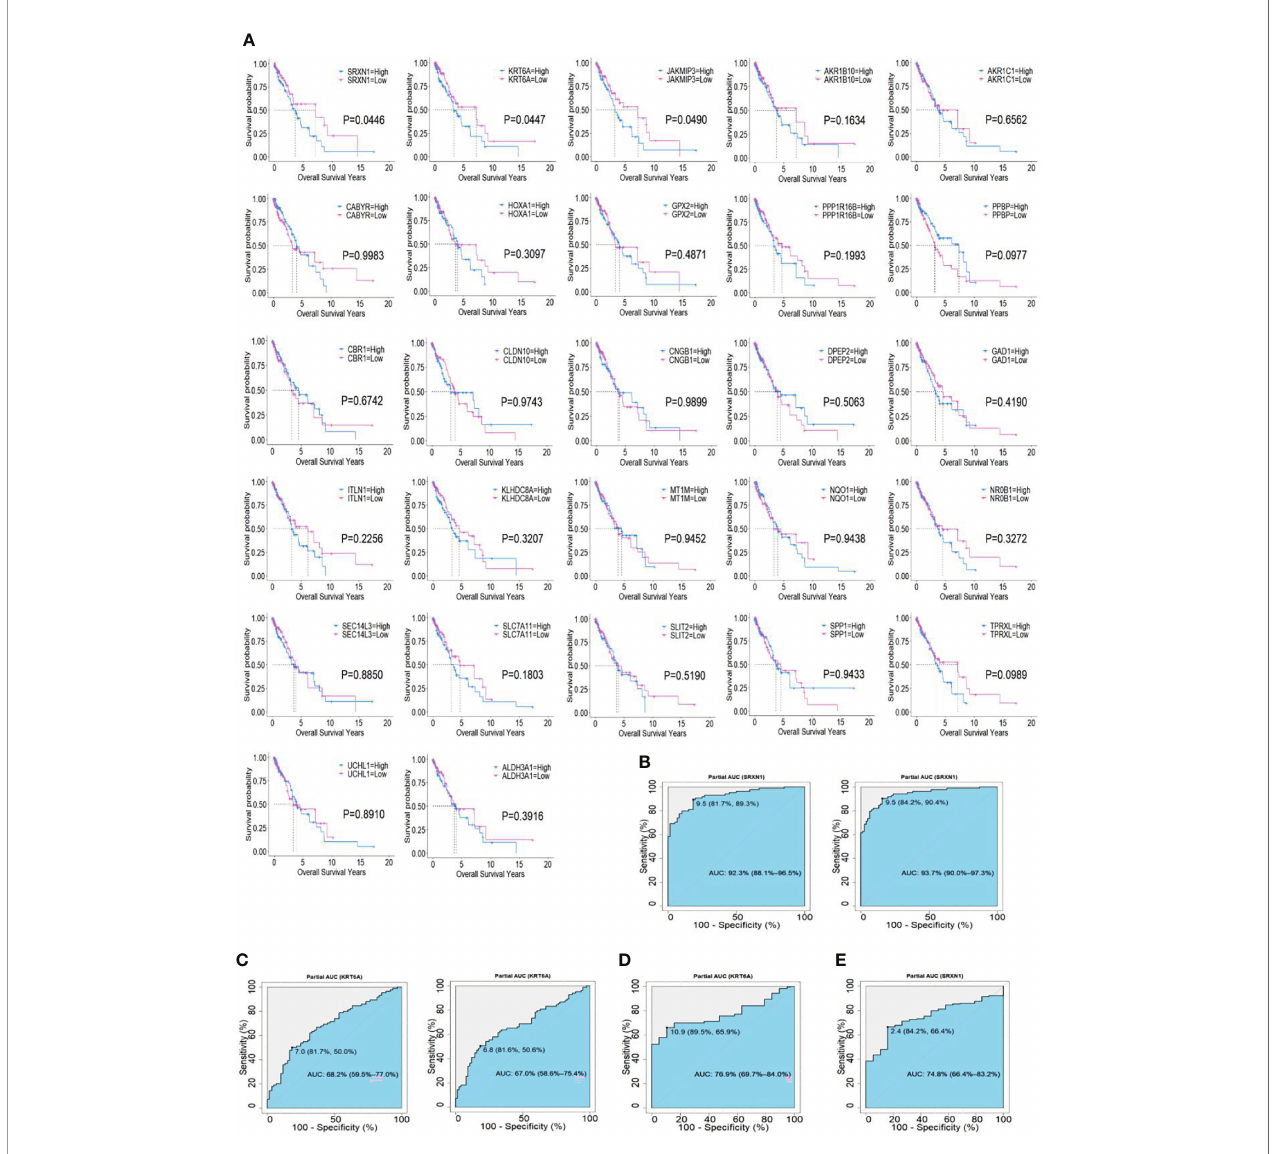
FIGURE 3 | Associations of two top hub smoking-related genes (SRGs) with overall survival in lung cancer patients via Kaplan – Meier and Cox regression analyses. (A) Kaplan – Meier curves of 27 hub SRGs; (B) receiver operating characteristic (ROC) curves of SRXN1 in the GSE18385 and GSE76324 datasets. (C) ROC curves of KRT6A in the GSE18385 and GSE76324 datasets. (D) ROC curves of SRXN1 in The Cancer Genome Atlas (TCGA). (E) ROC curves of KRT6A in TCGA.